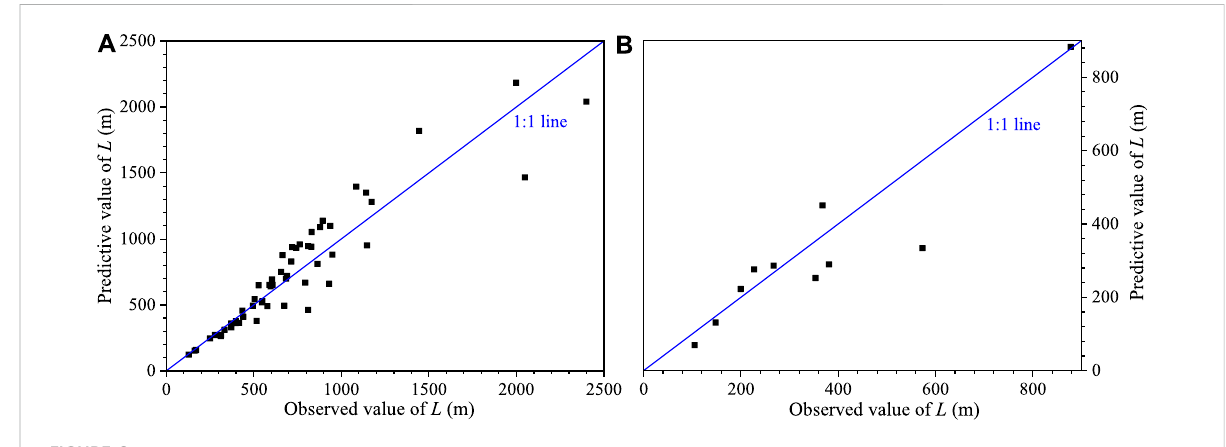
FIGURE 6 The comparison between the observed and predicted travel distances for Eq. 9: (A) Comparison results of 54 de fl ected-type rock avalanches; (B) comparison results of an independent validation dataset of 10 de fl ected-type rock